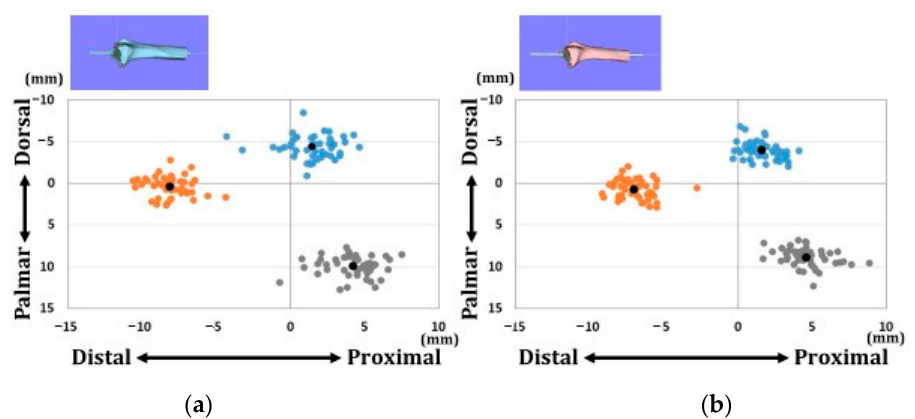
Figure 5. Coordinates of three reference points in the sagittal plane. ( a ) Results of coordinates for males. ( b ) Results of coordinates for females. Orange dots indicate the radial styloid process: reference point (1). Gray dots indicate the sigmoid notch volar edge: reference point (2). Blue dots indicate the sigmoid notch dorsal edge: reference point (3). Black dots indicate average positions for each reference point. The values of 3DRI and 3DPT were 24.2 ± 4.0/25.7 ± 3.1° and 10.9 ± 5.1/13.2 ± 4.4° for